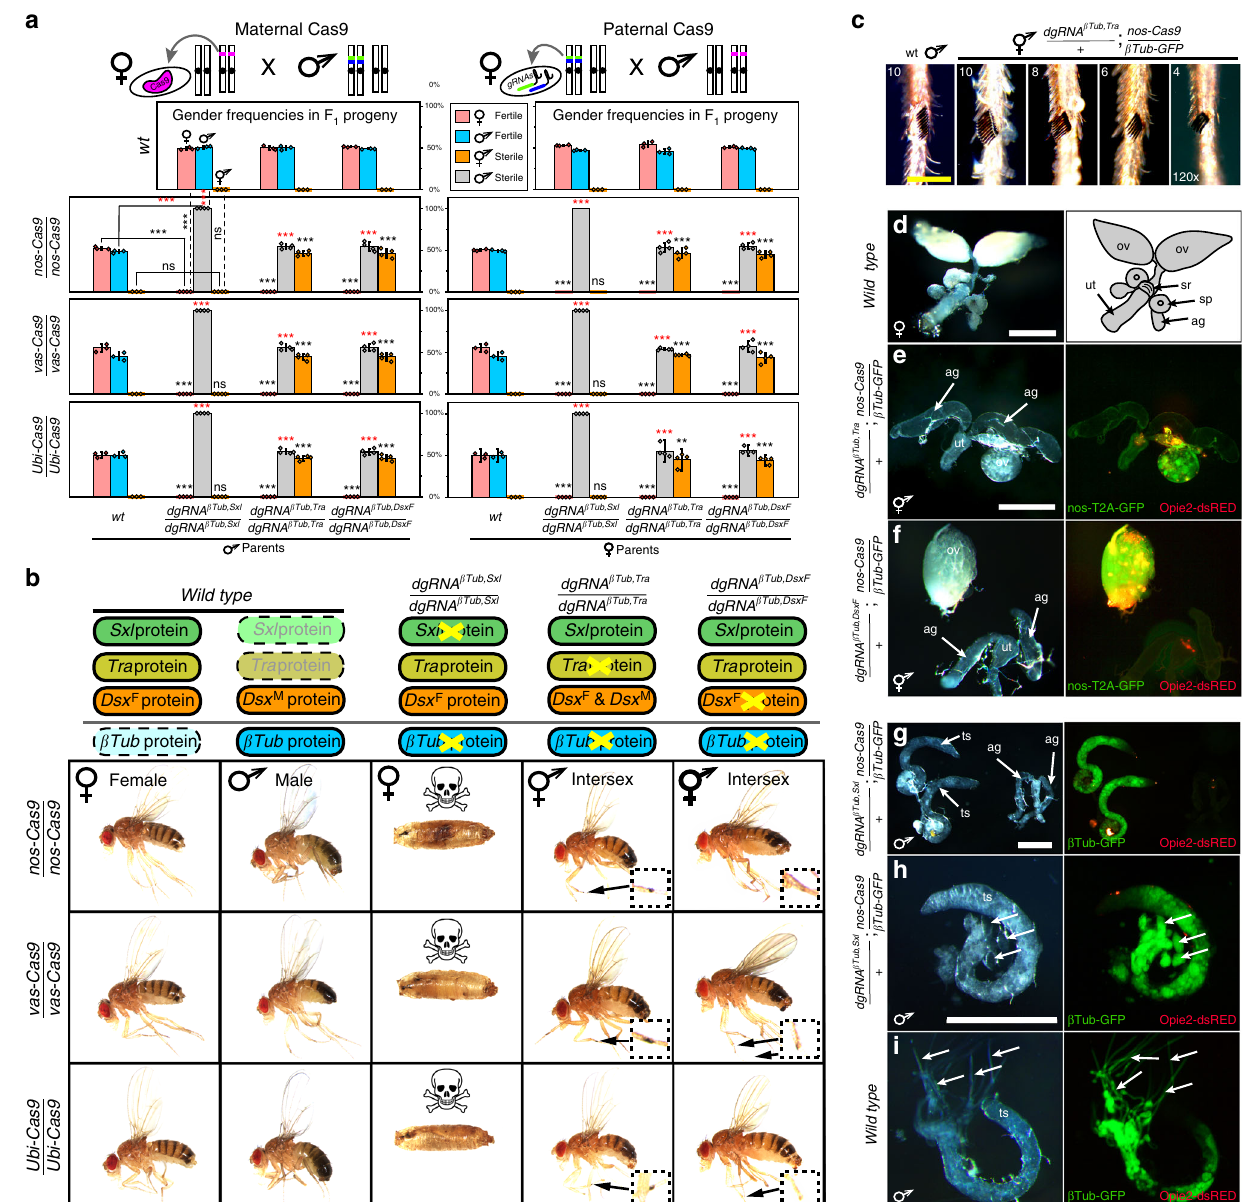
Fig. 2 Development and characterization of multiple highly ef fi cient pgSIT systems. a Gender ( ♀ , ♂ , and ⚥ ) frequencies of trans-heterozygous F 1 progeny resulting from crosses between double gRNAs ( dsRNA ) and Cas9 homozygous lines. Three dgRNAs, each targeting sxl , tra , or dsx combined with β Tub , were bidirectionally crossed with three Cas9 lines driven by nanos ( nos ), vasa ( vas ), and Ubiquitin-63E ( Ubi ) promoters and were suf fi cient to ensure complete penetrance of both female lethality/masculinization and male sterility in each reciprocal cross (Supplementary Figs. 1, 2). Gender frequencies and fertility in trans-heterozygotes were compared with those in the corresponding progeny of control crosses with Cas9 (bar groups to the left, solid lines) or dgRNAs (top panels, dashed lines) and wt fl ies. Bars represent means± SD for three/four independent groups of parental fl ies. P> 0.01**, P> 0.001*** by a t test assuming unequal variance (black *) or, for male sterilization by Pearson ’ s chi-squared test for contingency tables (red *). b Order of targeted gene in the sex- determination pathway (top) and the corresponding knockout phenotype in progeny. Phenotypes of dgRNAs directed knockouts and intersex morphology in comparison to wt females and males. β Tub , Sxl double-knockout females perish during pupal stages (Supplementary Fig. 3). dgRNA β Tub,Tra / + ; nos-Cas9/ + intersexes, but not dgRNA β Tub,DsxF / + ; nos-Cas9/ + intersexes, had sex combs, magni fi ed inside inserts. c Variable expressivity of the number of sex comb bristles in β Tub , Tra double-knockout intersexes. Scale bar shows 100 µ m. d Internal reproductive organs in wt females: two ovaries ( ov ), seminal receptacle ( sr ), double spermatheca (s p ), two accessory glands ( ag ), and uterus (ut). e Many dgRNA β Tub,Tra / + ; nos-Cas9/ + intersexes had one rudimentary ovary, and organs that resembled male accessory glands. f Many dgRNA β Tub,DsxF / + ; nos-Cas9/ + intersexes developed only a single ovary often times not connected with an oviduct and had organs that resembled male-speci fi c accessory glands. g – h Male internal reproductive system in dgRNA β Tub,Sxl / + ; nos-Cas9/ + male. In comparison with wt testis i , elongated cysts with maturing spermatids were not found in the dgRNA β Tub,Sxl / + ; nos-Cas9/ + testis ( h , i : arrows). Scale bars correspond to 500 µ m